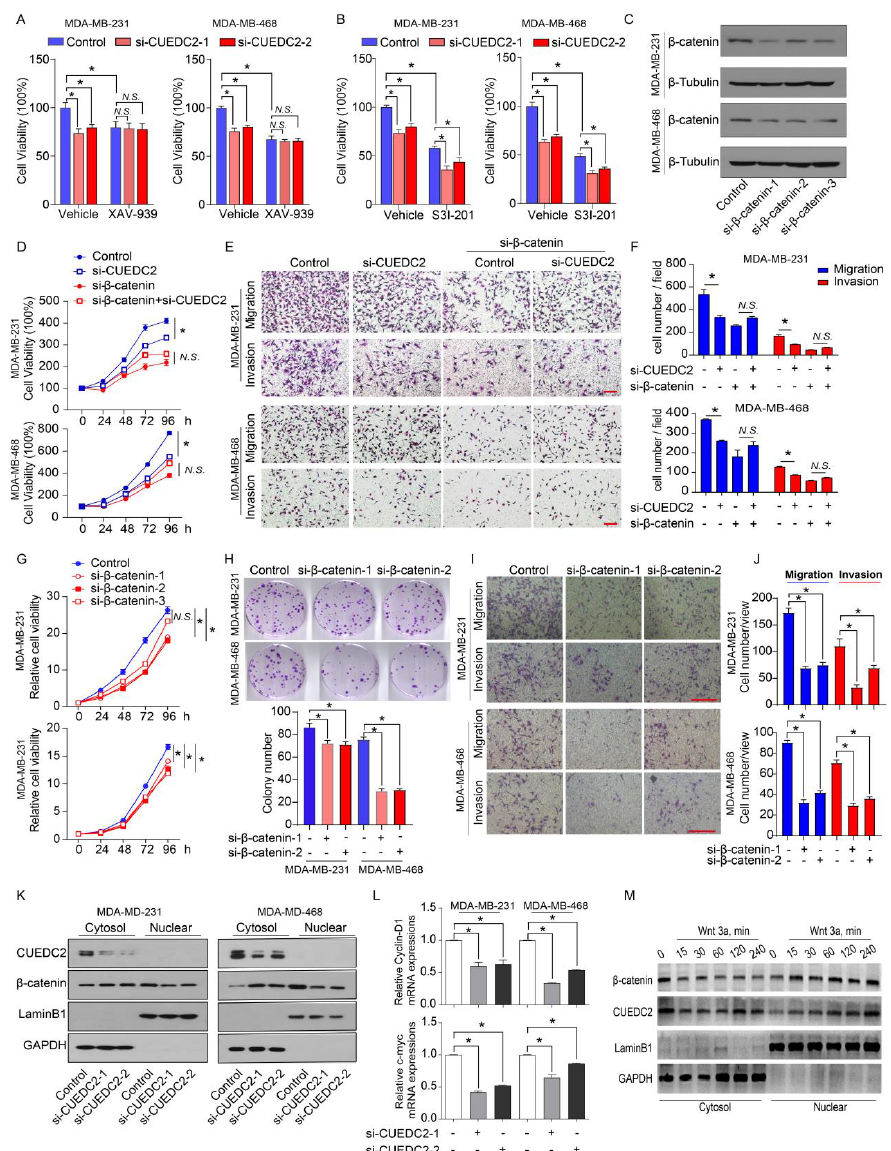
Figure 4. CUEDC2 promotes TNBC progression via interacting with β -catenin and accelerating its nuclear translocation. ( A , B ) Effects of CUEDC2 knockdown on proliferation of naïve, XAV-939-treated ( A ) or S3I-201-treated; ( B ) MDA-MB-231 cells and MDA-MB-468 cells. XAV-939, 1 µ M, an inhibitor of β -catenin; S3I-201, 25 µ M, an inhibitor of STAT3. ( C ) Western blot results show the efficiency of β -catenin knockdown in MDA-MB-231 and MDA-MB-468 cells. ( D ) Influences of β -catenin knock- down on the effects of CUEDC2 in modulating TNBC cell proliferation. The RNA sequences of si- CUEDC2-2 (si-2) and si- β -catenin-1 were used to analyze the interactions of CUEDC2-2 and β -catenin. ( E , F ) Representative images ( E ) and statistical results ( F ) showing the influences of β -catenin knock- down on the effects of CUEDC2 in modulating TNBC cell migration and invasion. ( G – J ) Effects of β -catenin knockdown on proliferation ( G ), clonal formation ( H ), migration and invasion ( I , J ) of MDA-MB-231 and MDA-MB-468 cells. ( K ) Effects of CUEDC2 knockdown on subcellular location of β -catenin in MDA-MB-231 and MDA-MB-468 cells. ( L ) Effects of knockdown of CUEDC2 on mRNA levels of c-myc and cyclin D1, two target genes of β -catenin in MDA-MB-231 cells. ( M ) Effects of Wnt 3a, a classical Wnt ligand, on nuclear translocation of β -catenin and CUEDC2. * p < 0.05, One-way ANOVA in ( A , B , F , H , J,L ); two-way ANOVA in ( D , G ). Data are representative of three independent experiments. Bar = 50 µ m, “ N.S. ” means no